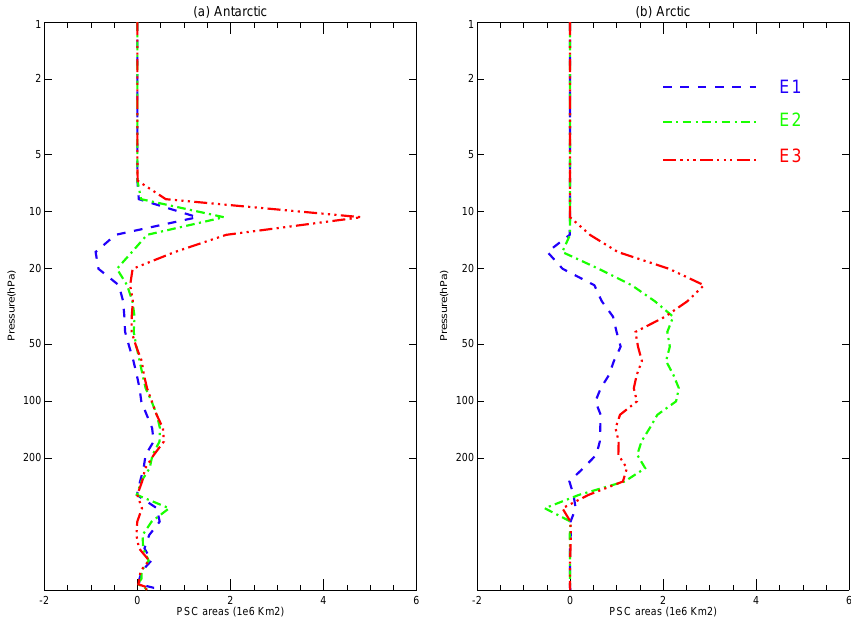
Figure 6. Profiles of differences in PSC area ( × 10 6 km 2 ) averaged over the last 10 years during winter, between WACCM experiments E1 and E0 (blue dashed line), E2 and E0 (green dashed dotted line), and E3 and E0 (red dashed dotted line) in (a) Antarctic JJA and (b) Arctic